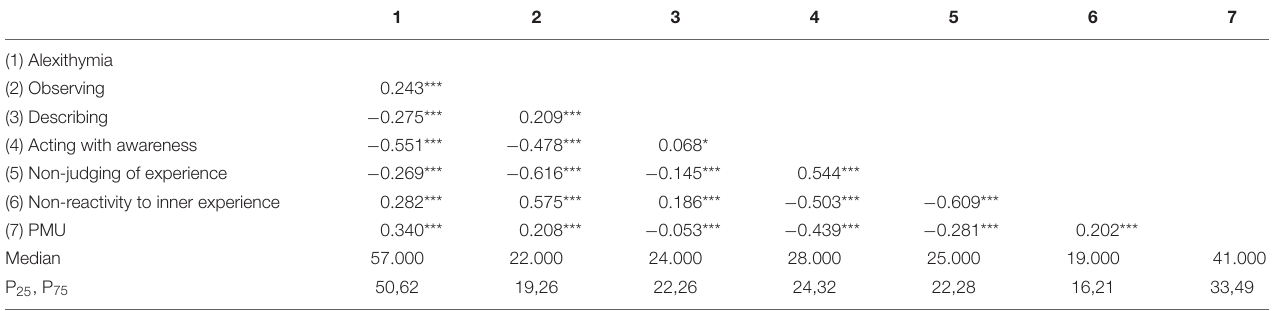
TABLE 1 | Spearman correlation coefficients of all the investigated variables.